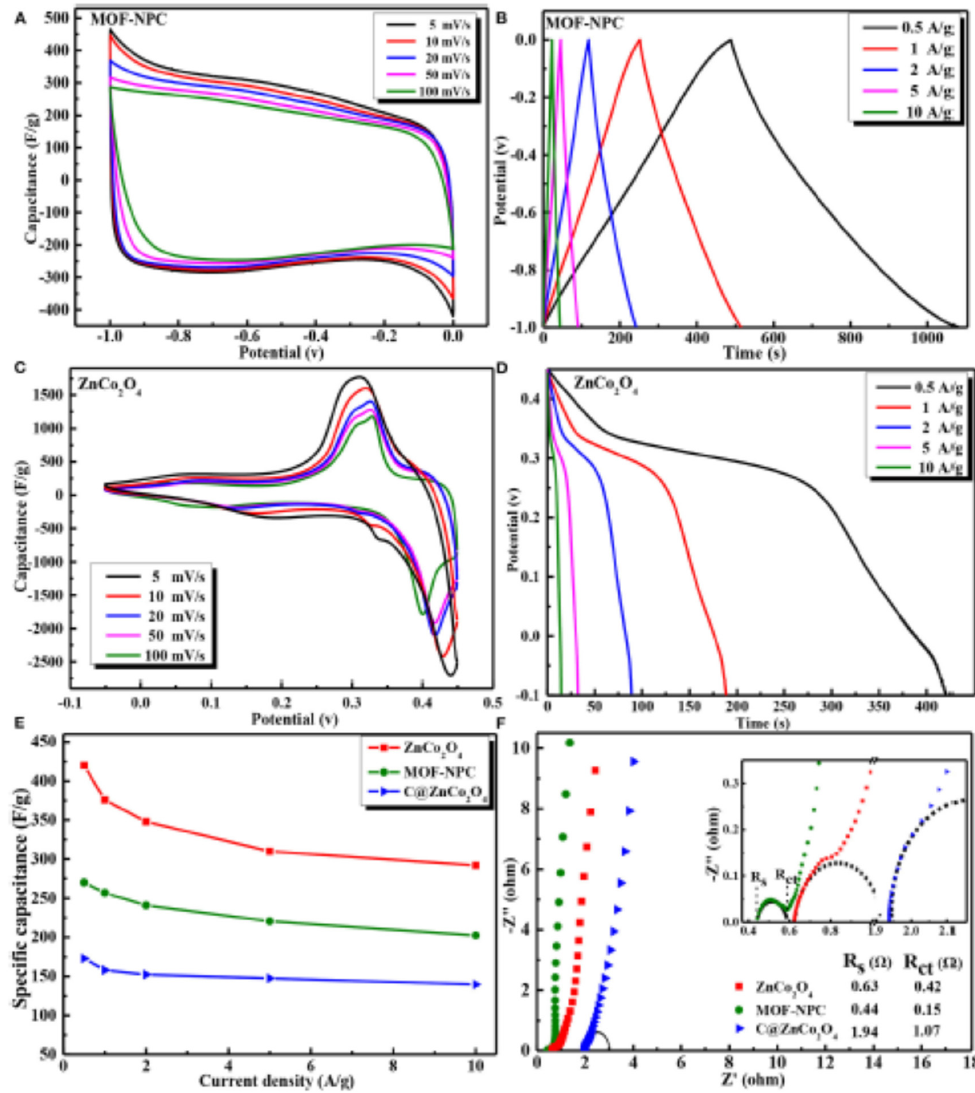
Figure 20. The electrode electrochemical performances of the Zn/Co–MOF-derived material: CV curves at various scan rates of ( A ) MOF-NPC and ( C ) ZnCo 2 O 4 ; GCD curves at various current densities of ( B ) NPC and ( D ) ZnCo 2 O 4 . ( E ) Specific capacitance at different current densities of MOF-NPC, C@ZnCo 2 O 4 , and ZnCo 2 O 4 . ( F ) EIS curves of MOF–NPC, C@ZnCo 2 O 4 , and ZnCo 2 O 4 [98]. Reproduced with permission.